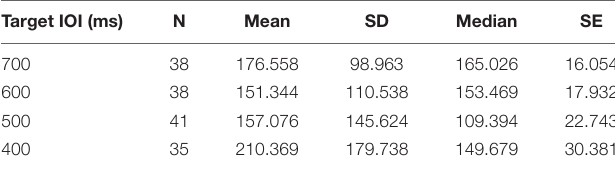
TABLE 3 | Tempo mismatch of infant drumming at each target IOI. Target IOI (ms)